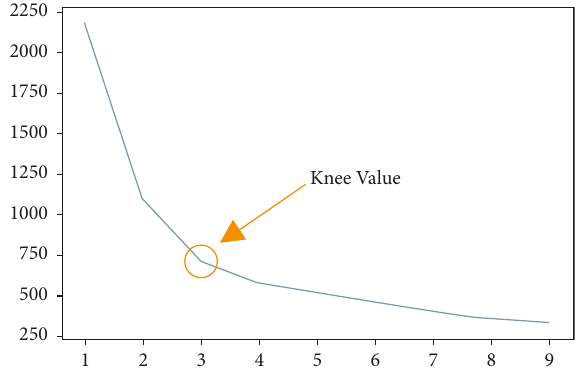
Figure 2: Determine the knee value of the elbow method.